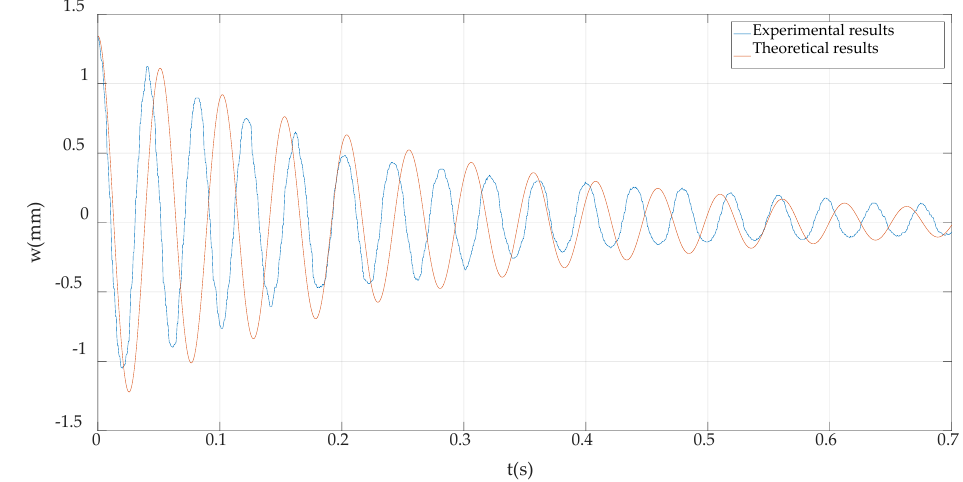
Figure 6. The time–displacement curves under the initial displacement of 1.342 mm.